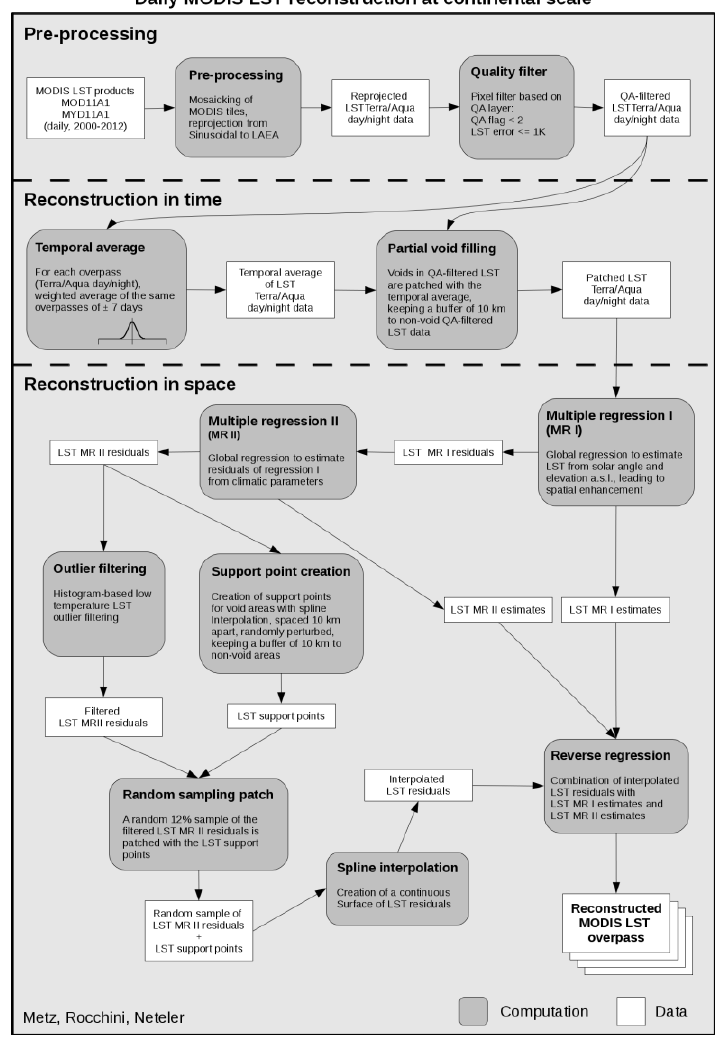
Figure 3. Flow chart of the reconstruction process. The process uses as input the MOD11A1 and MYD11A1 products. The output is a mosaicked, reprojected, filtered and gap-filled